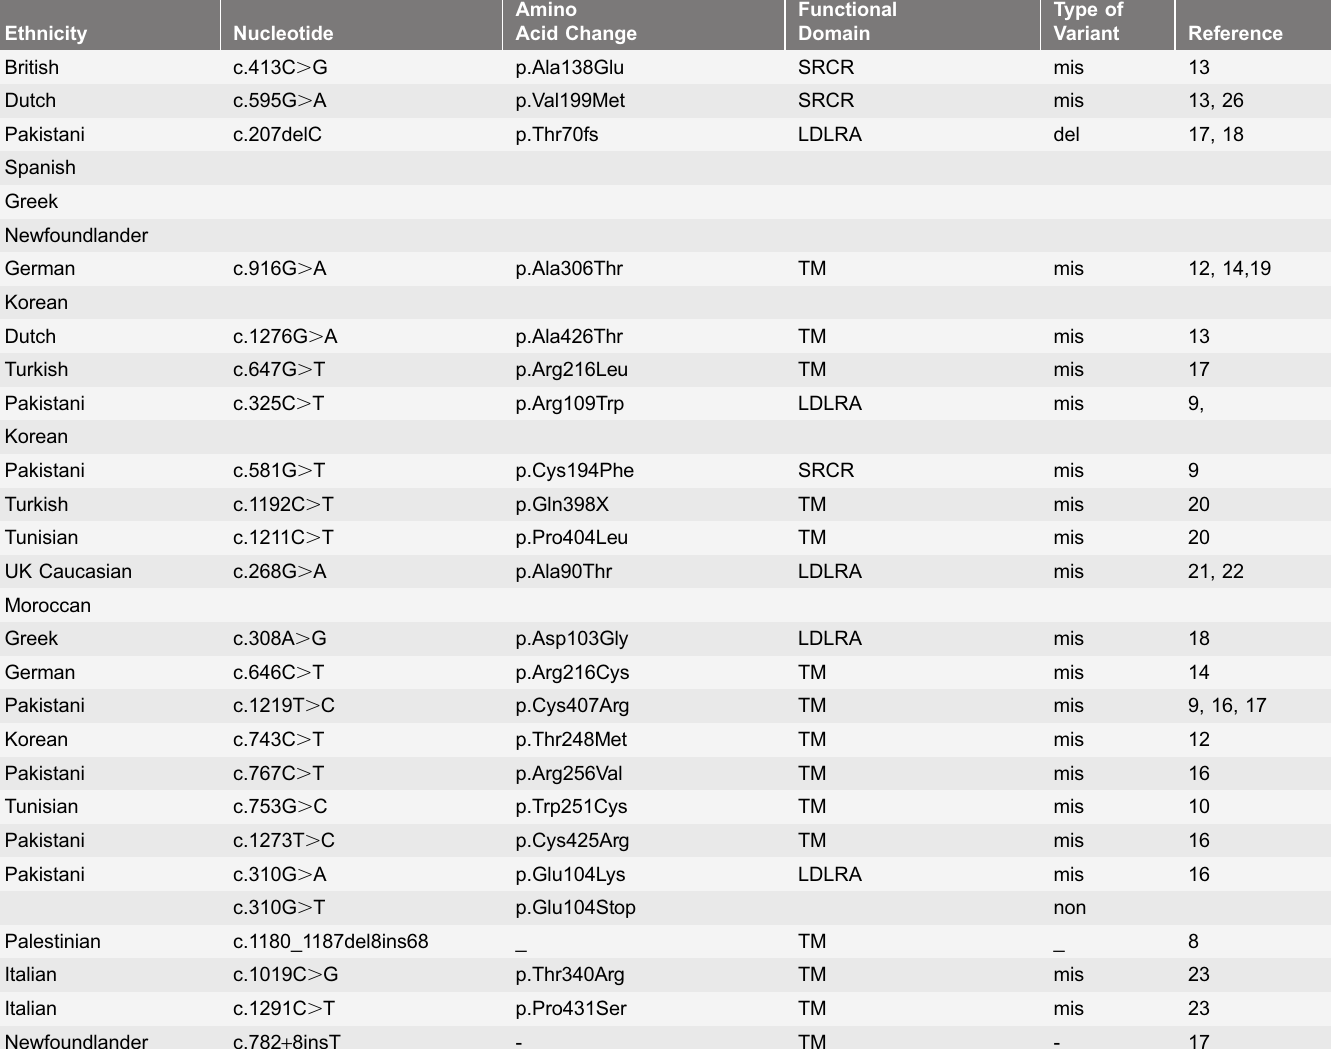
Table 3. Pathogenic deafness mutations in TMPRSS3 identified in previous